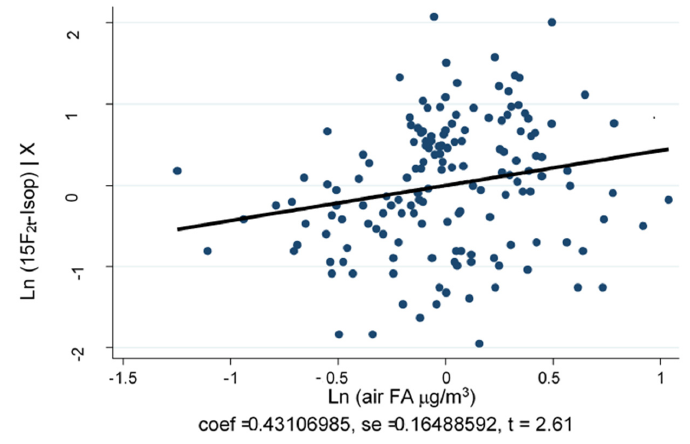
Figure 2. Correlation between Air-formaldehyde (FA) and 15-F 2t -IsoP. The correlation is significant and positive (Spearman’s rho = 0.241, p = 0.003).